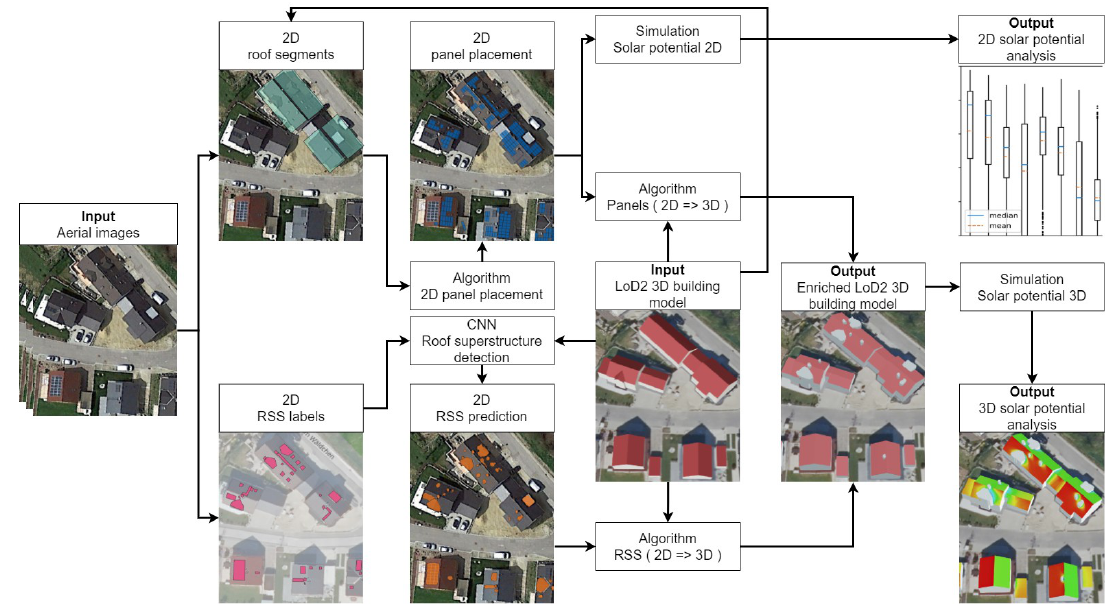
Figure 1. Overview on the input data, model components of bringing information from 2D to 3D. CNN = Convolutional neural network, RSS = Roof superstructures.